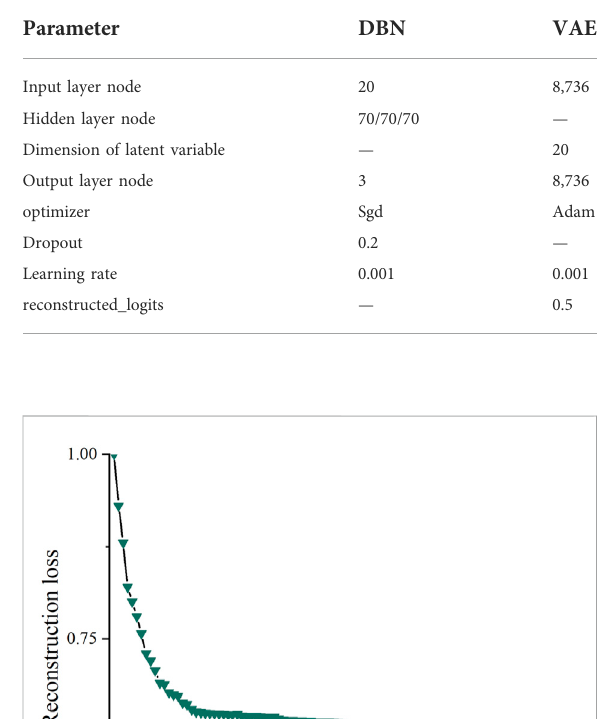
TABLE 6 The parameters employed by VAE-DBN.